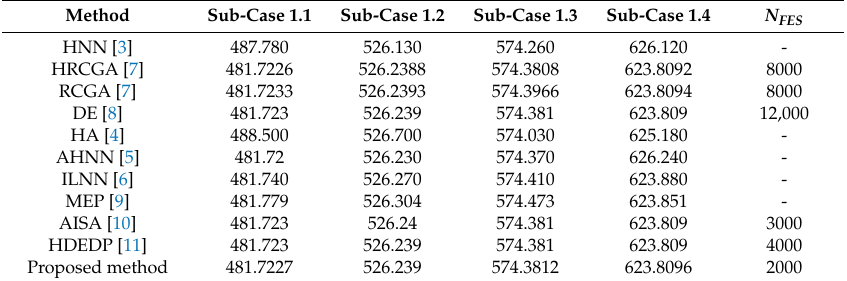
Table 3. The result comparison about cost ($/h) between methods in case